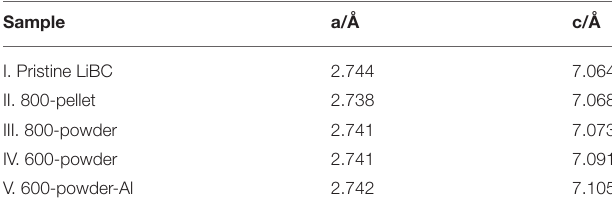
TABLE 1 | Lattice parameters a and c for five LiBC samples according to the XRD patterns. Sample a/Å